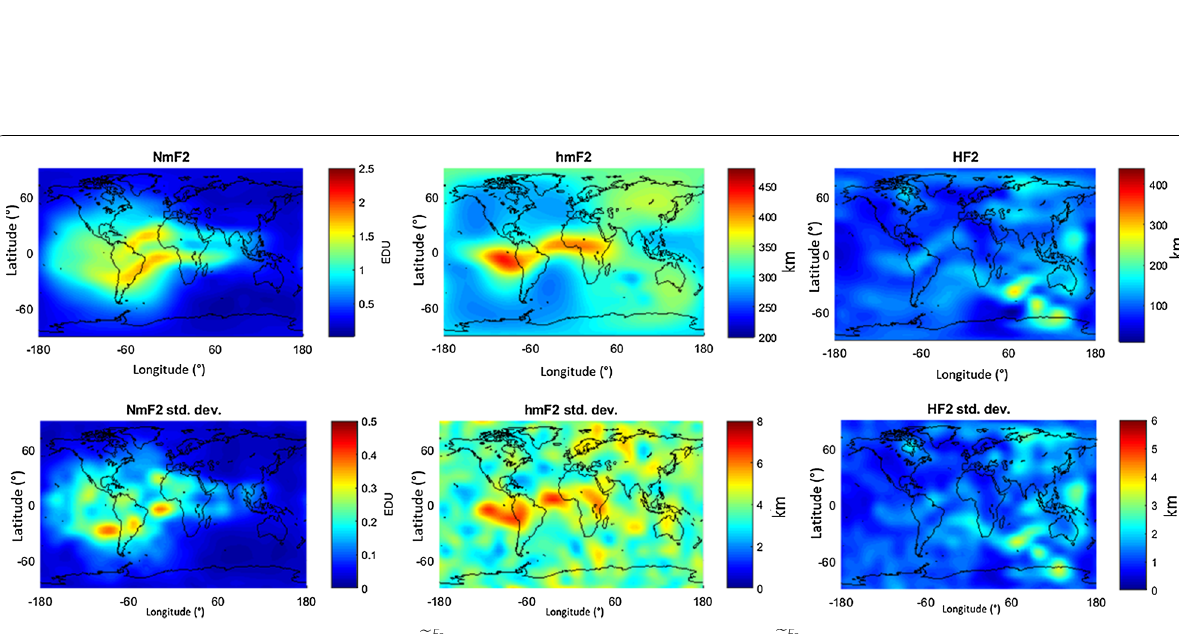
Fig. 9 Maps of the estimated key parameters mid) and the scale